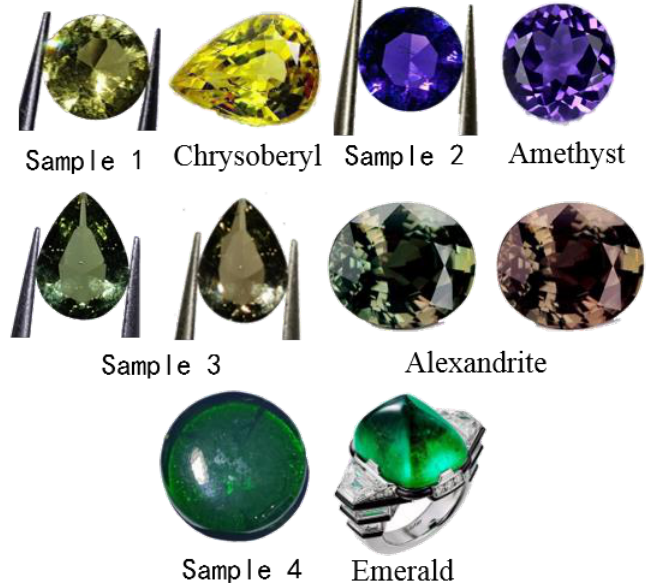
Figure 7. Comparison of imitation gemstone glass samples with natural gemstones.